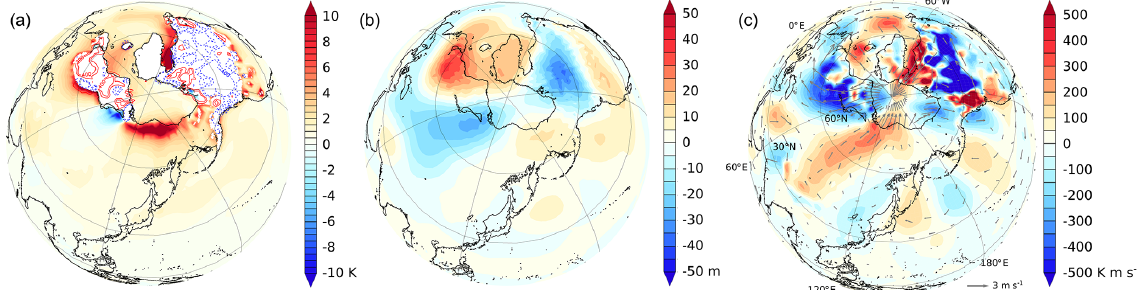
Figure 5. Impact of the prescribed LGM ice-sheet topography (GLAC-1D versus ICE-6G) on simulated LGM climate anomalies during the boreal summer season (JJA). Results are shown as the CESM experiment LGM_CAM5_noVeg minus LGM_CAM5_noVeg_ice6g. (a) Near- surface temperature anomalies (K). (b) The 500hPa geopotential height anomalies (m; anomalies calculated after subtracting the zonal mean). (c) Vertically averaged meridional sensible heat transport anomalies (Kms − 1 ; shading). Vectors in panel (c) show 500hPa wind anomalies (ms − 1 ). In panel (a) , regions covered by continental ice sheets during the LGM have been masked out. The red (blue) contours in panel (a) depict positive (negative) differences in ice-sheet height (m) between the GLAC-1D and ICE-6G reconstructions (GLAC-1D – ICE-6G; 300m contour interval). The LGM coastlines are given in black.